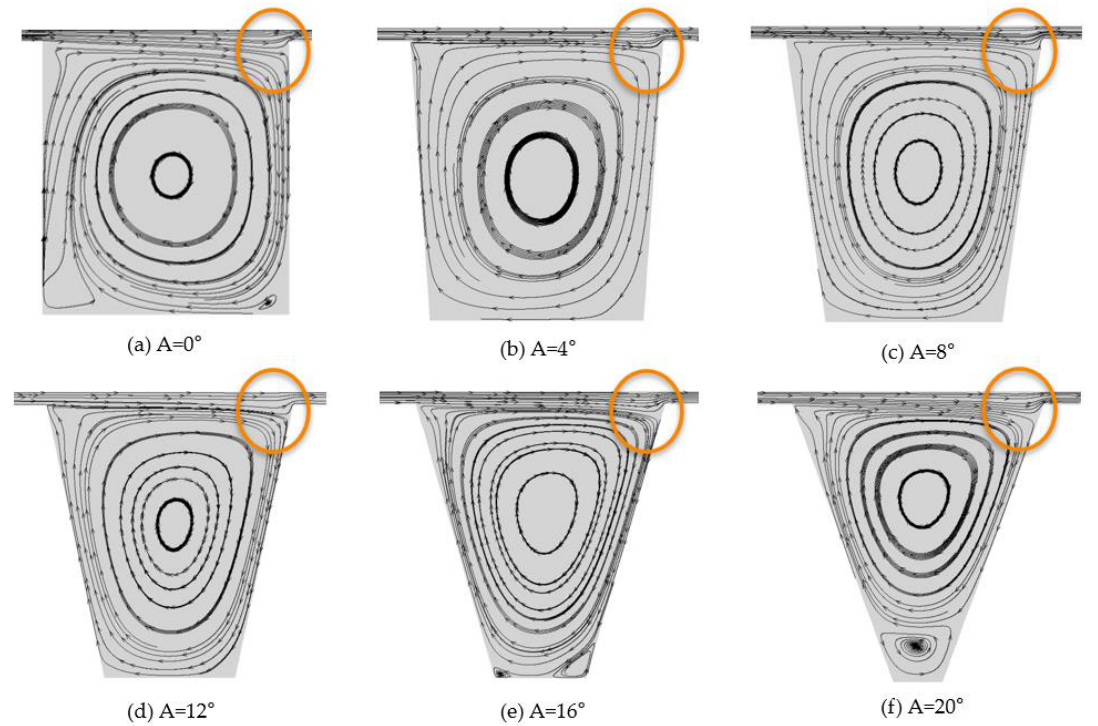
Figure 11. ( a – f ) The effect of varying the tooth inclination angle ( A ) on the streamlines of the labyrinth seal under a pressure ratio of 2. Table 4. Jet divergence angles for several tooth inclination angles.